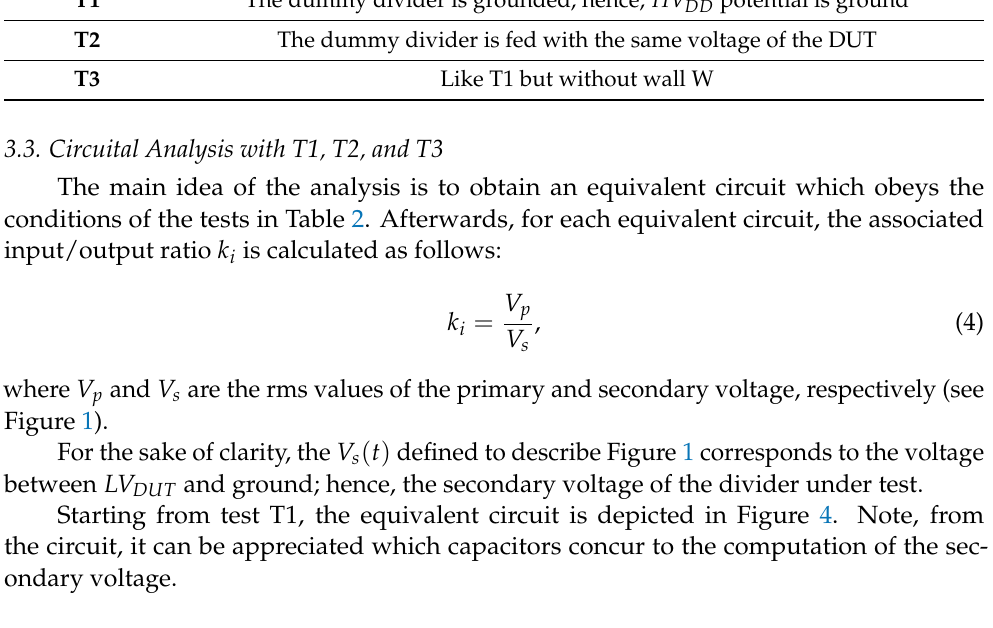
Table 2. Description of the test conditions considered in Section 3.2.